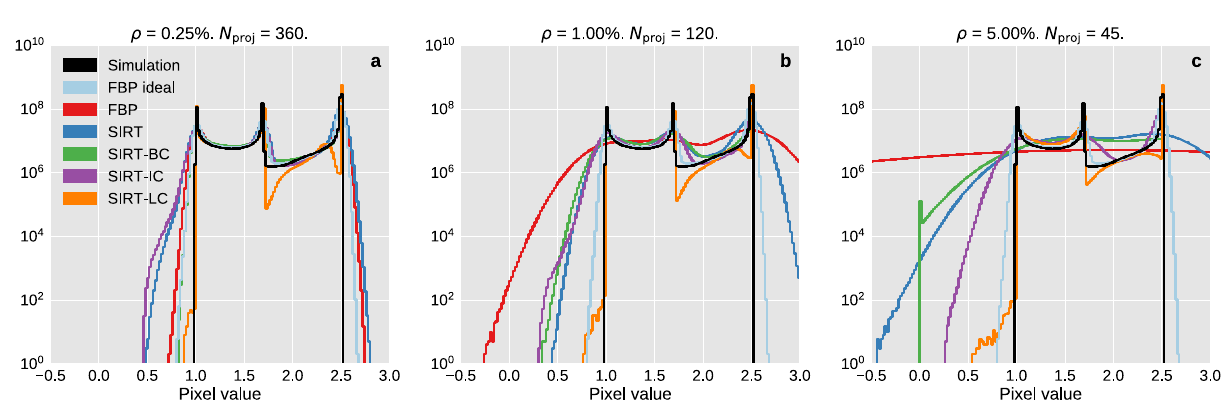
Figure 8. Histograms of the voxel values on a logarithmic scale of the ground truth image and the reconstructions. Plots ( a – c ) show histograms for reconstructions of data sets with 360 number of projections with 0.25% noise, 120 number of projections with 1.00% noise and 45 number of projections with 5.00% noise